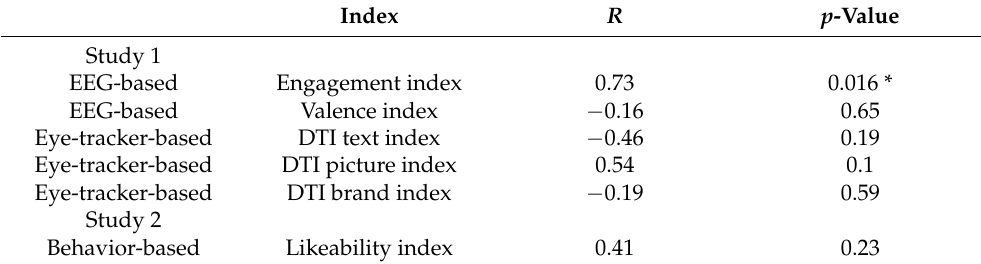
Table A1. Correlation of the indexes with population-level ad efficiency (session duration index).